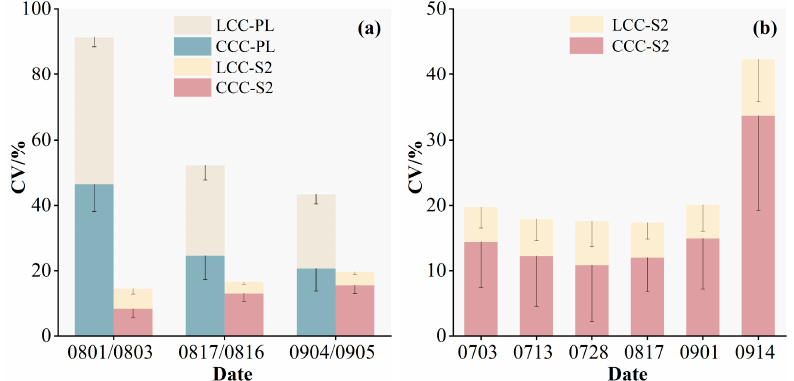
Figure 9. Uncertainties (i.e., CV) associated with chlorophyll retrieval using the hybrid model in di ff erent periods in ( a ) Dajianchang Town and ( b ) Youyi Farm.